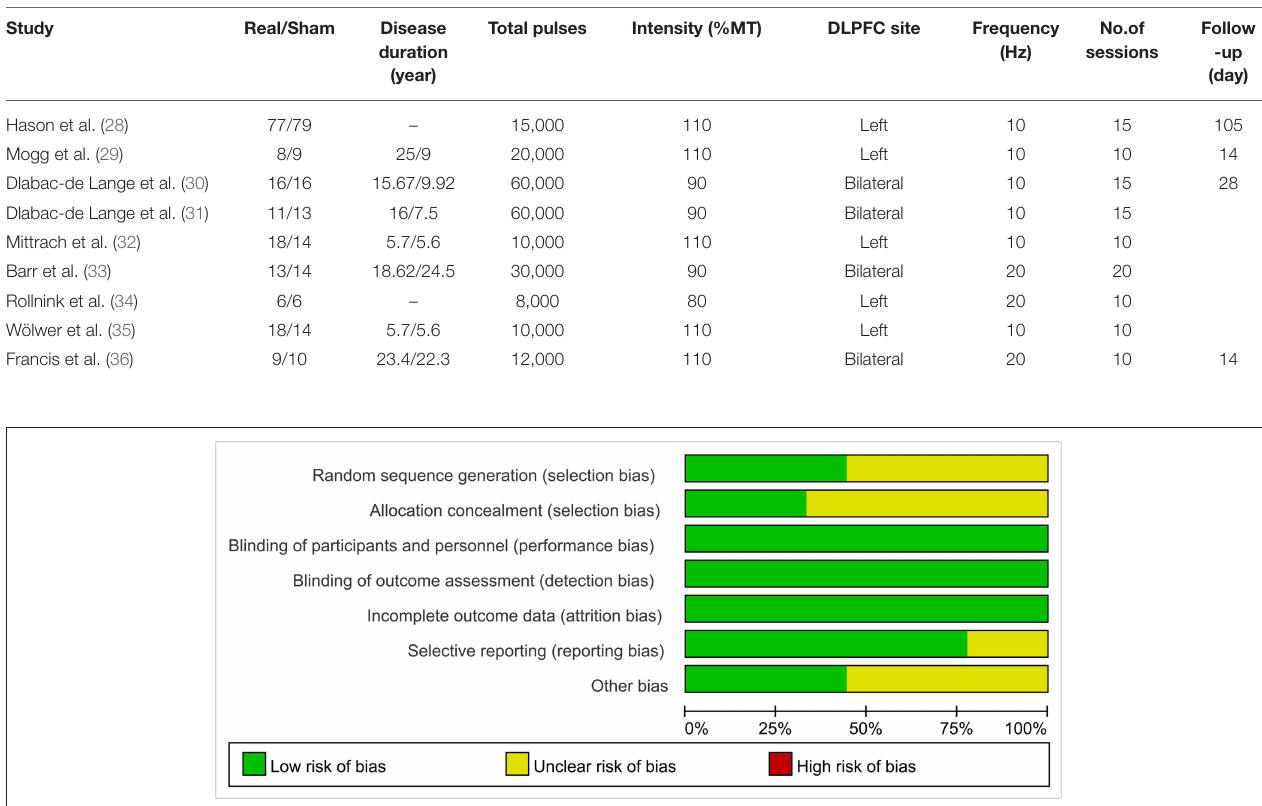
TABLE 2 | Characteristics of included studies.